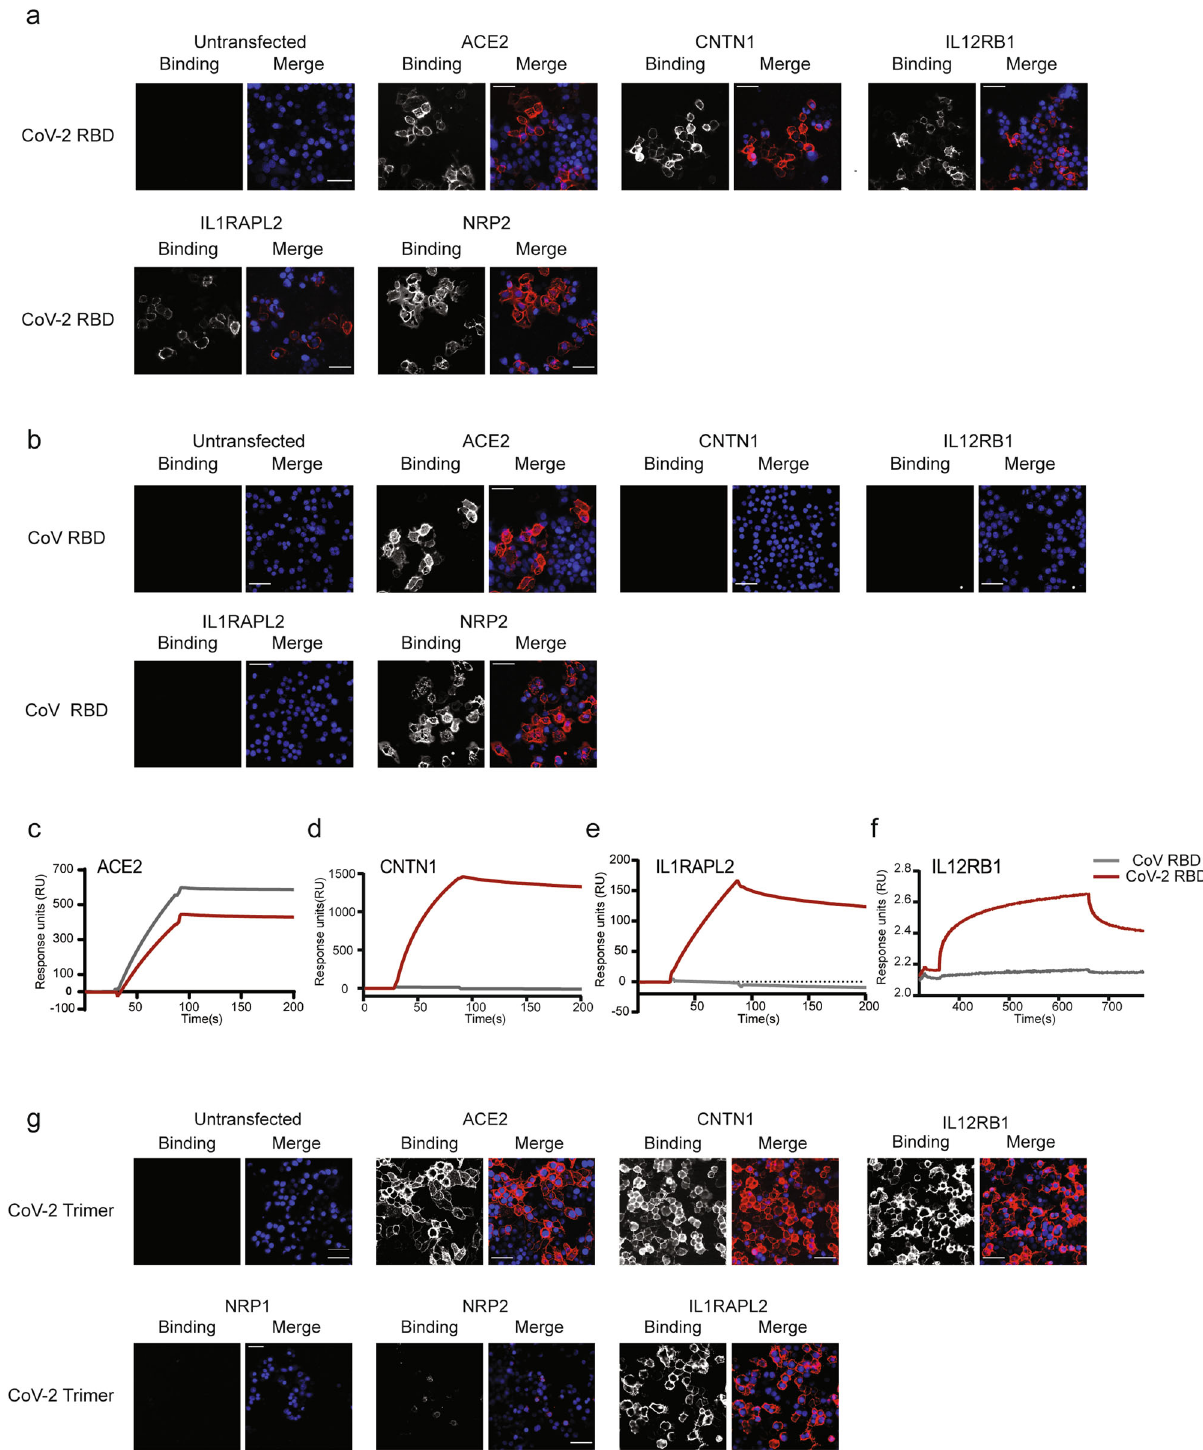
tissues (Fig. 5a, b), while IL12RB1 was predominantly expressed in immune and lymphoid cells, showing relatively higher expression in scRNA transcriptomes from lung cells (Fig. 5a, b). NRP2 was expressed across multiple tissues, showing relatively higher expression in the digestive and reproductive tract, among others (Fig. 5a, b). Interestingly, CNTN1 was highly and pre- dominantly expressed in nervous system tissue, with similar results at the single cell level (Fig. 5a,